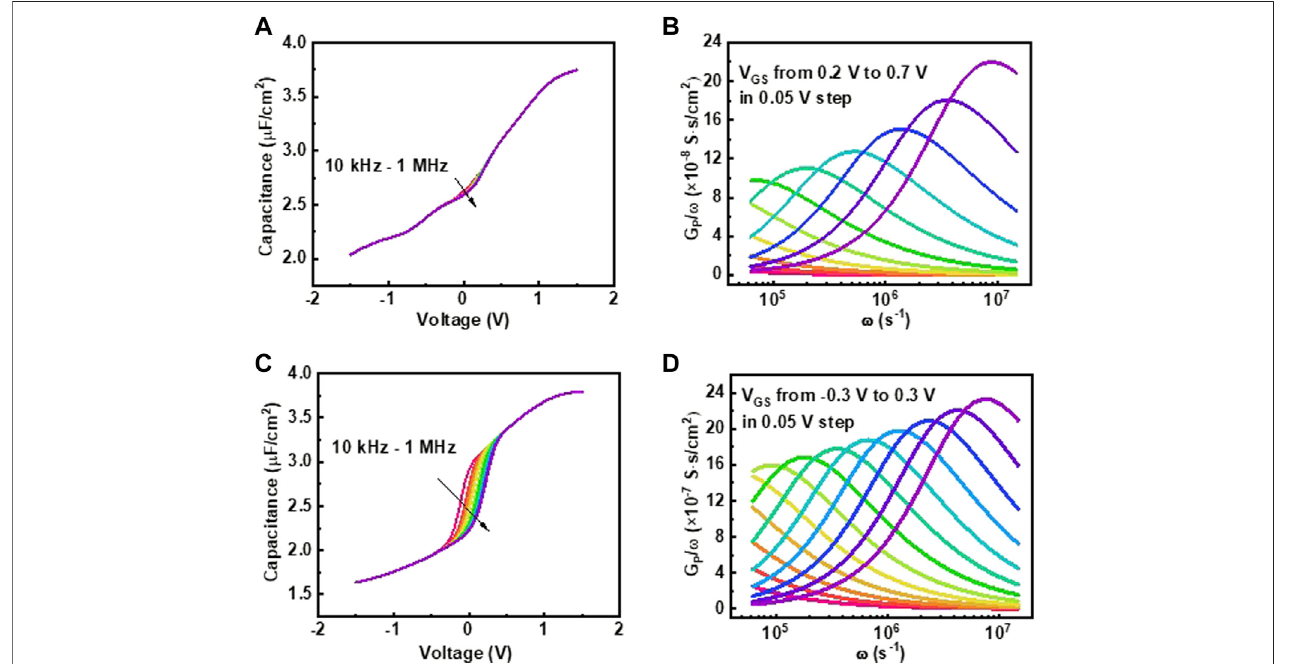
FIGURE 5 | Simulated (A) C – V and (B) G P / ω versus ω characteristics of the gate stack capacitor with the same structure as in Figure 1B , using D it of 10 12 cm − 2 eV − 1 . Simulated (C) C – V and (D) G P / ω versus ω characteristics of the gate stack capacitor with the same structure as in Figure 1B , using D it of 10 13 cm − 2 eV − 1